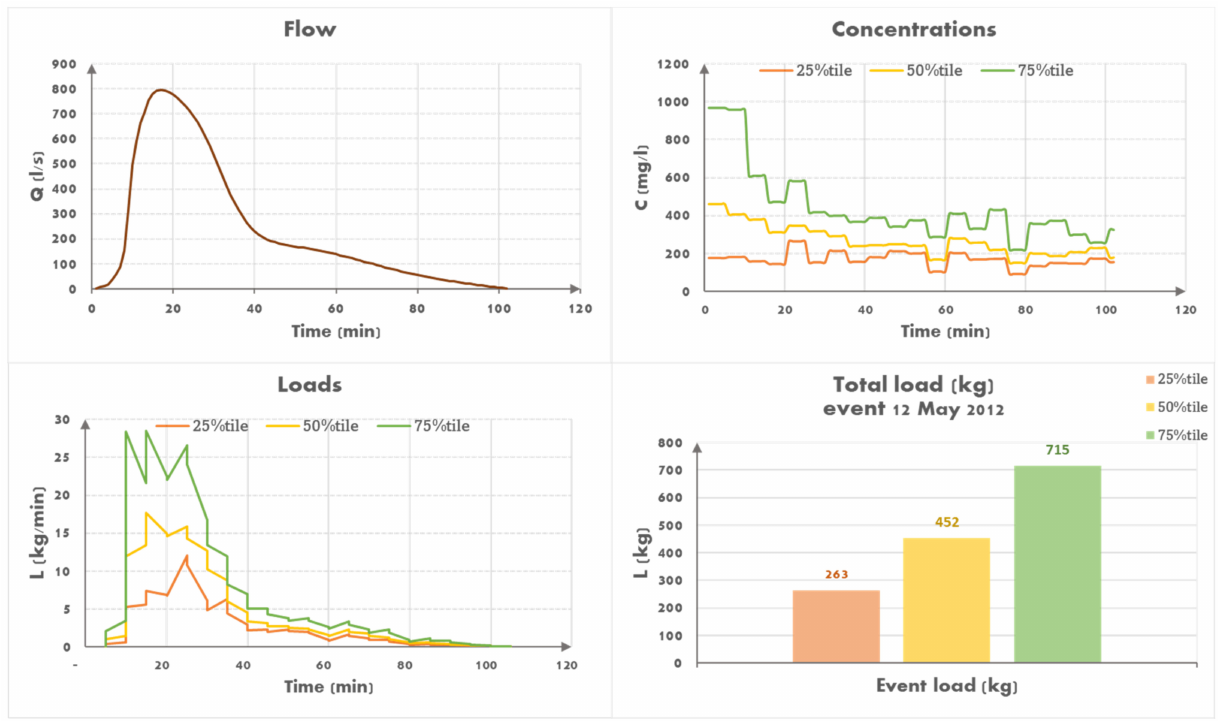
Figure 5. Examples of Cockle calculations: flow of overflow event determined by hydrodynamic modeling (Q), with corresponding stochastic COD key parameters (twenty-fifth, fiftieth, and seventy- fifth percentiles) (C), calculated COD load per percentile (L) and total event COD load L TOT per percentile. Event 12 May 2012, at CSO Herent